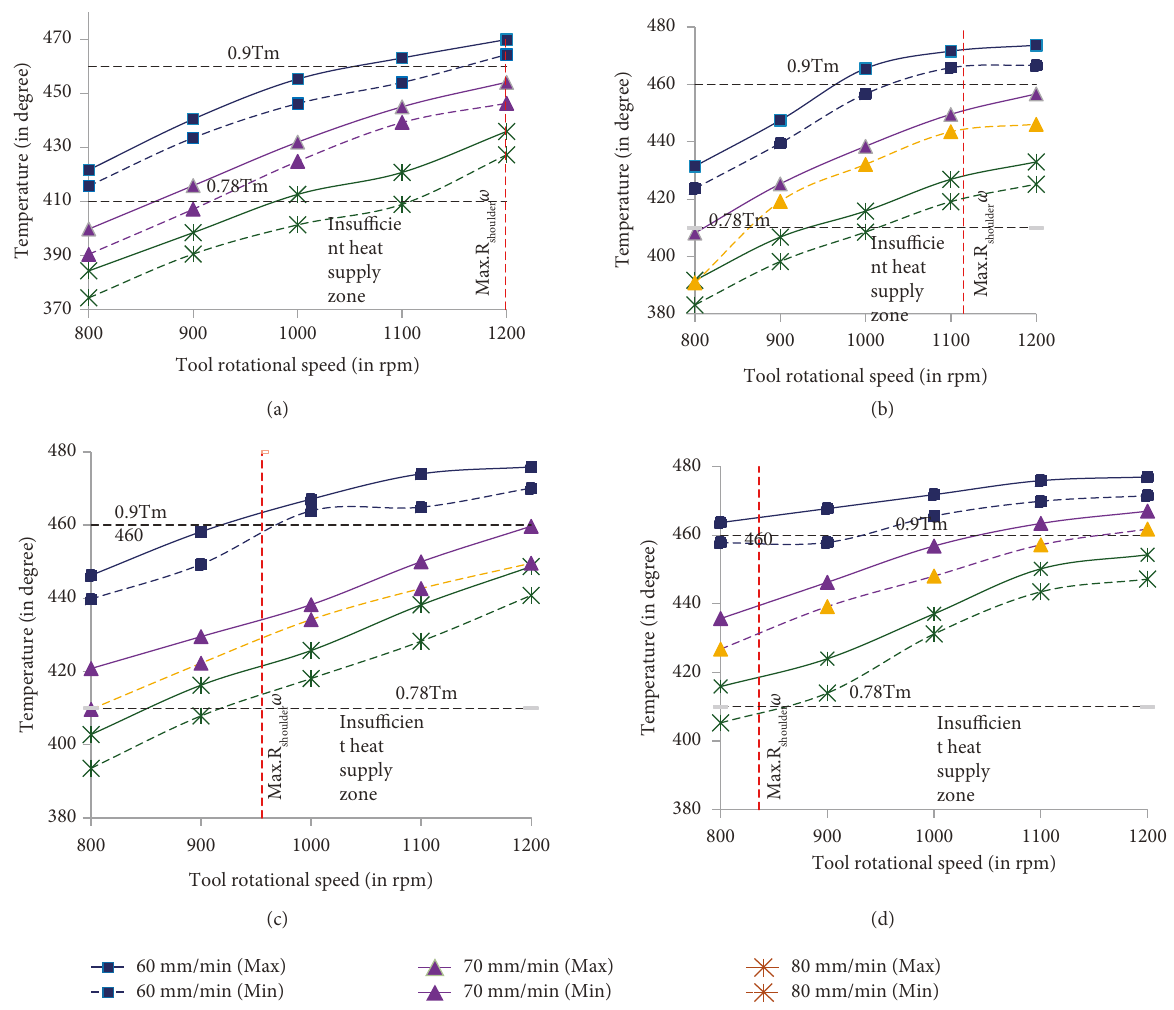
Figure 5: Temperature recorded at the top and bottom surfaces during the welding stage. (a) R R shoulder � 10.5mm; (d) R shoulder � 12mm.